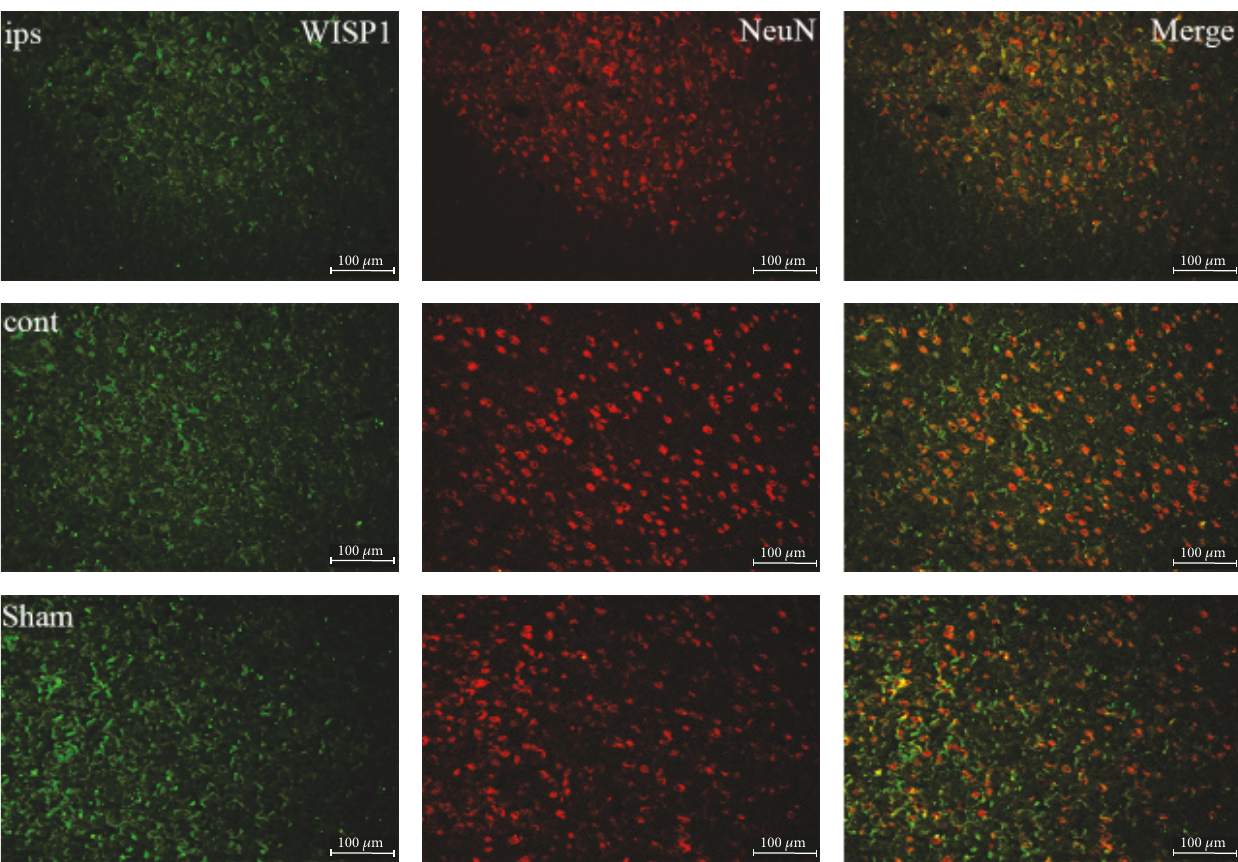
Figure 3: Double-labeling immuno fl uorescence of WISP1 and NeuN at 3 d after TBI. Green: WISP1; red: NeuN; cont: the control of ipsilateral 3d post-TBI group; ips: ipsilateral 3d post-TBI group; sham: sham group; bar =100 μ